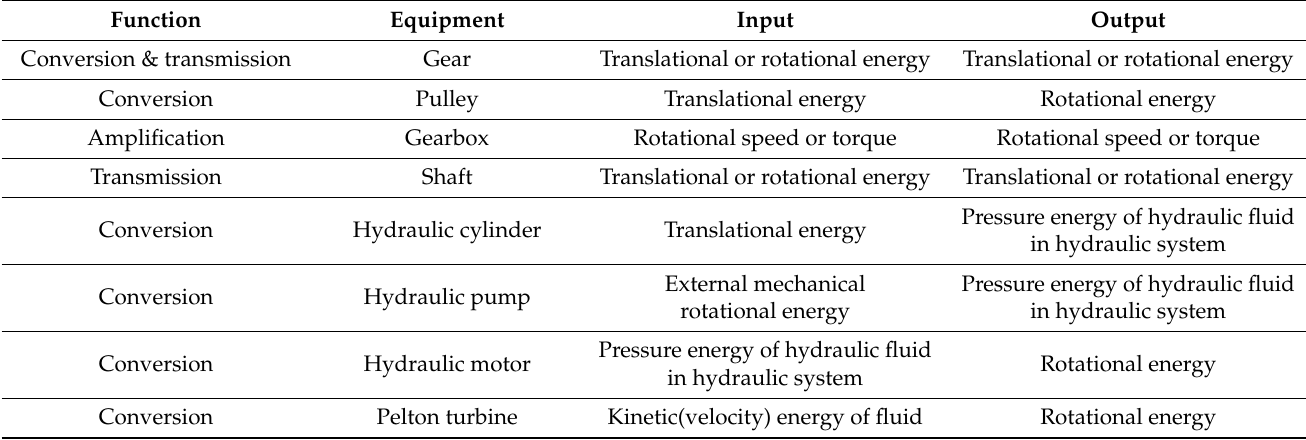
Table 1. Equipment and each input/output obtained through IDEF0 modeling.